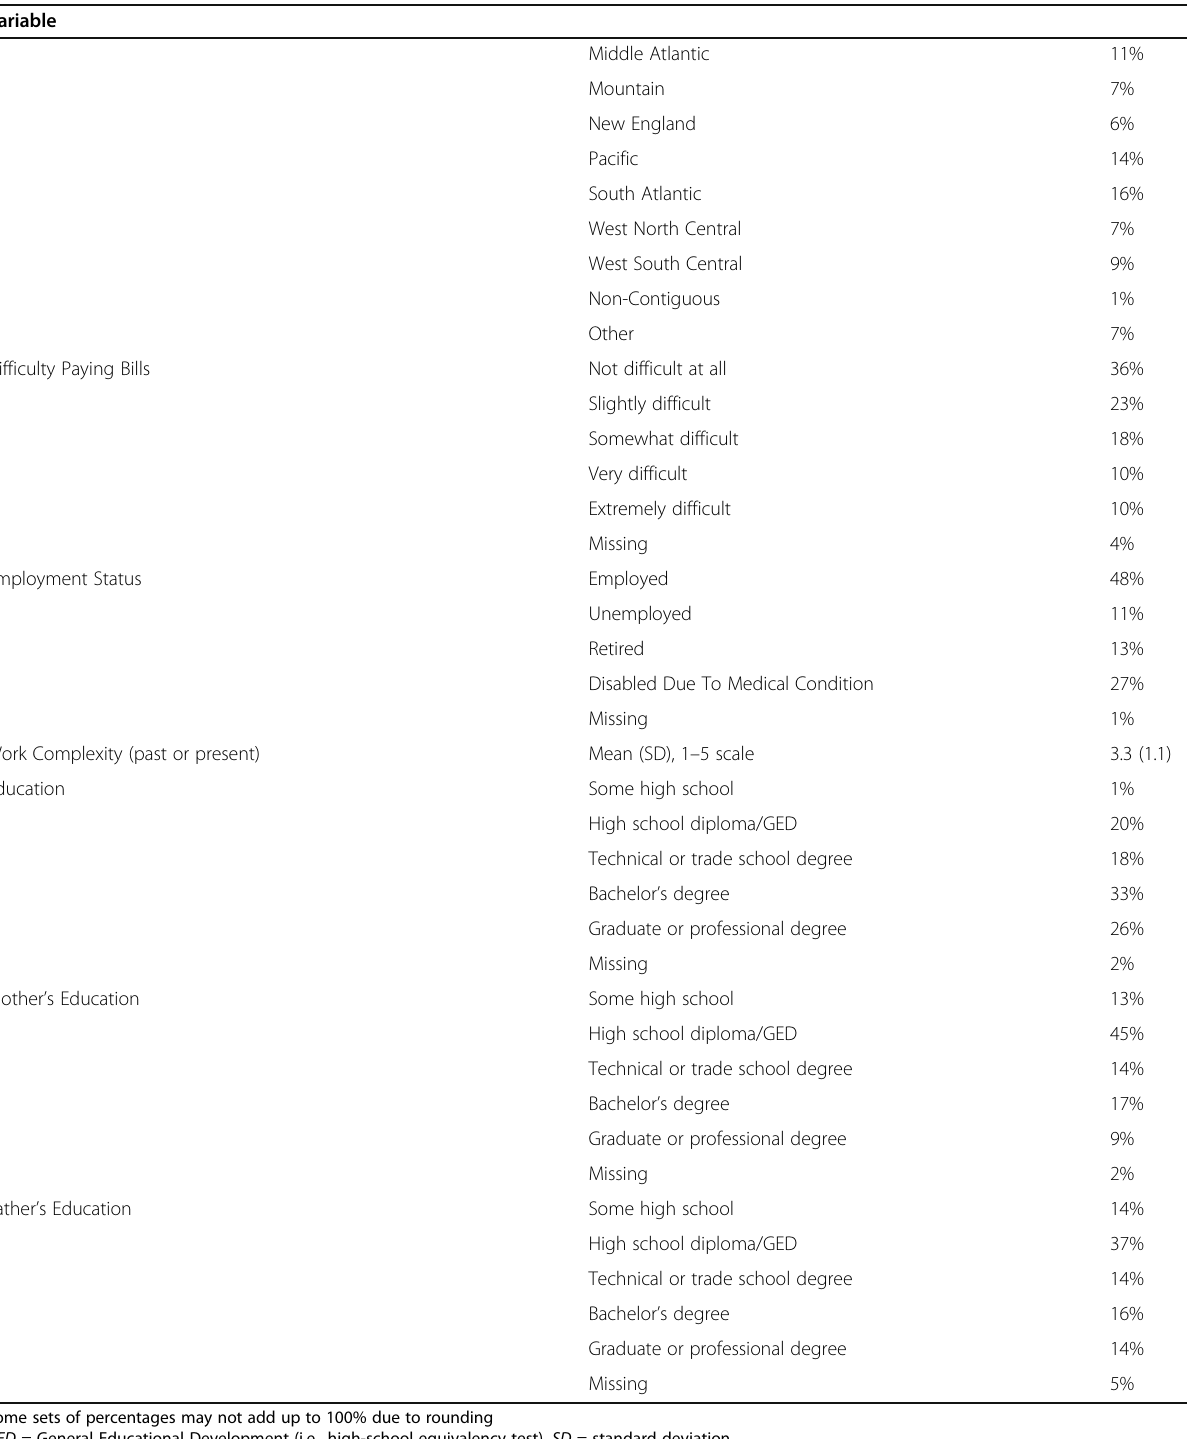
Table 1 Person-Level Demographic Characteristics ( N = 1481) (Continued)